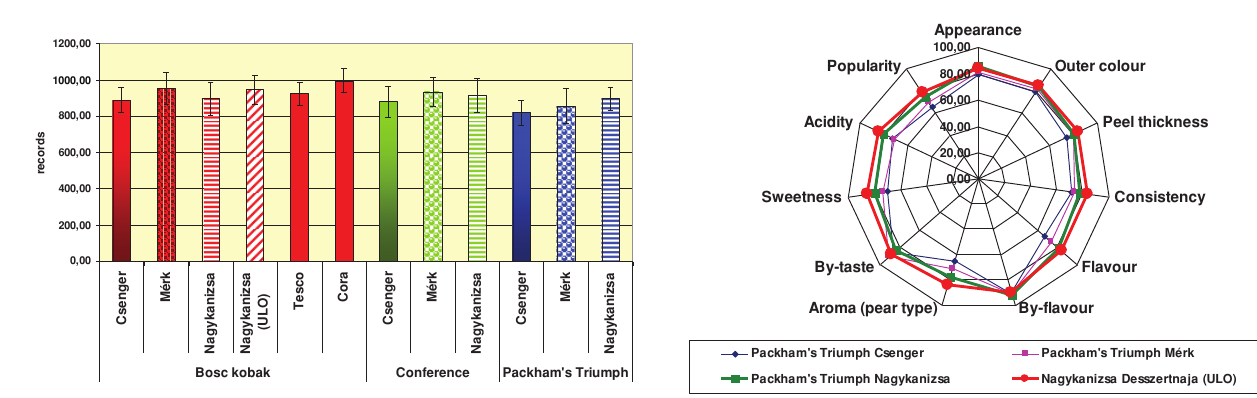
Figure 1. Records of sensorial ratings of fruits coming from different sources of three varieties